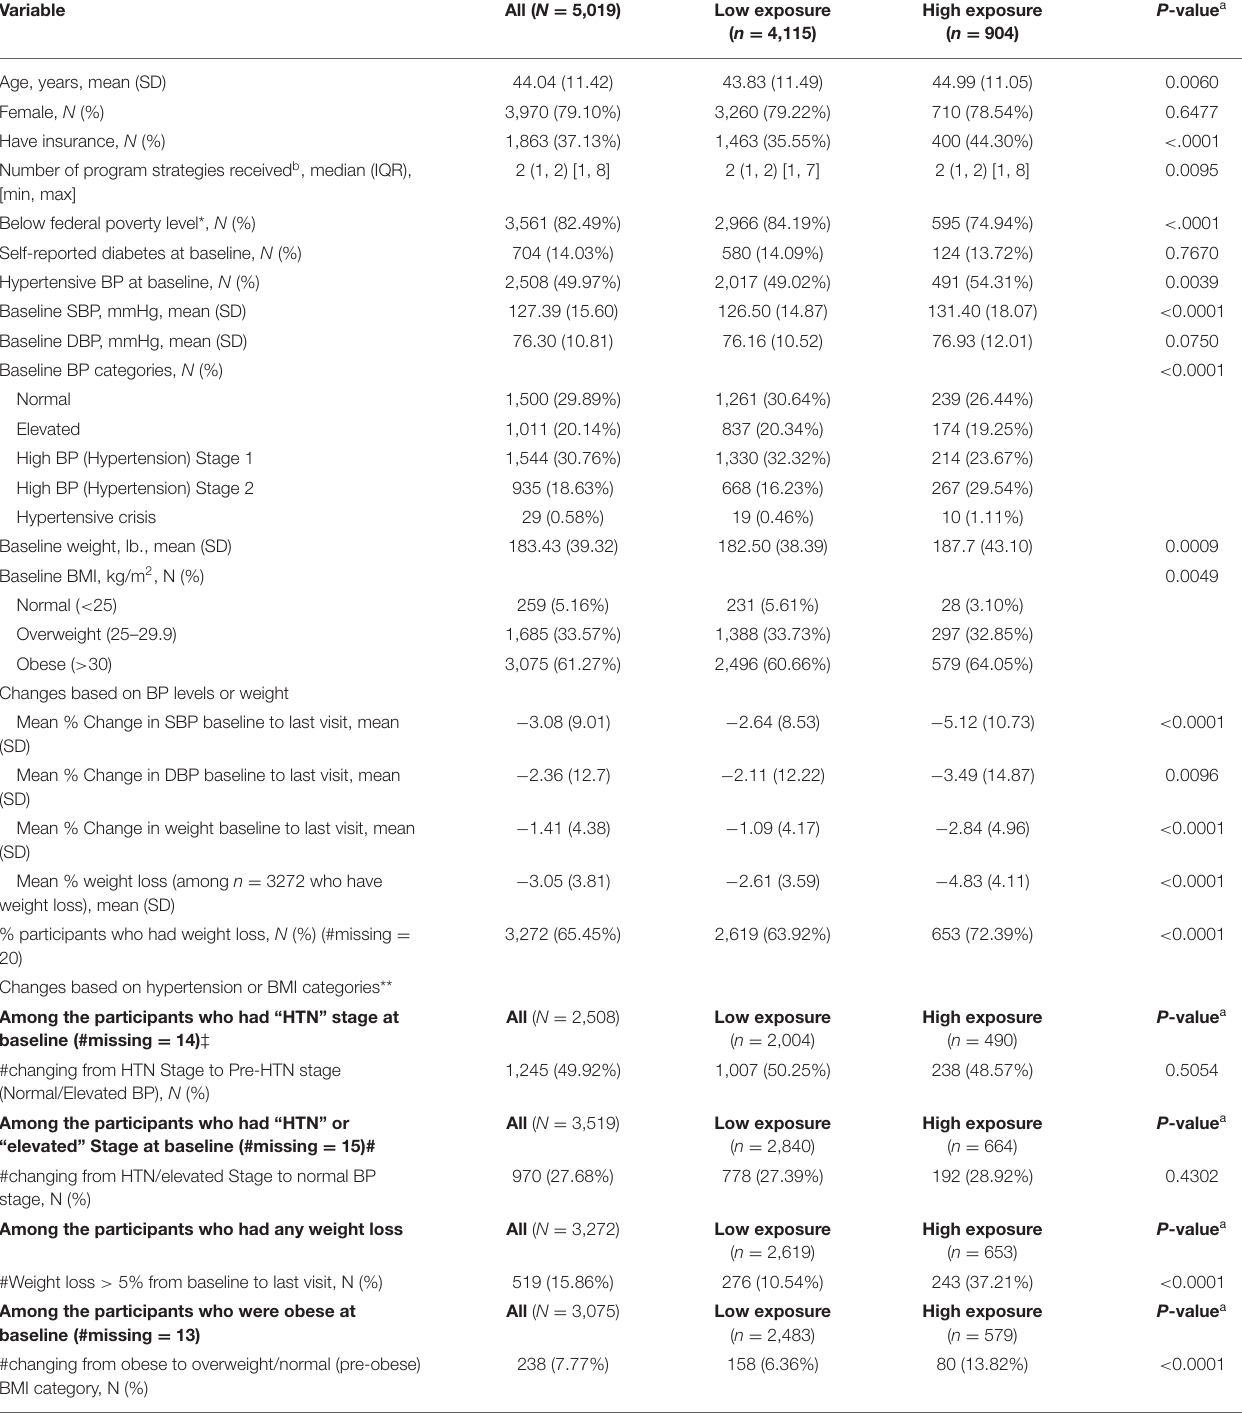
TABLE 1 | Baseline characteristics and descriptive changes of outcomes ( N = 5,019).